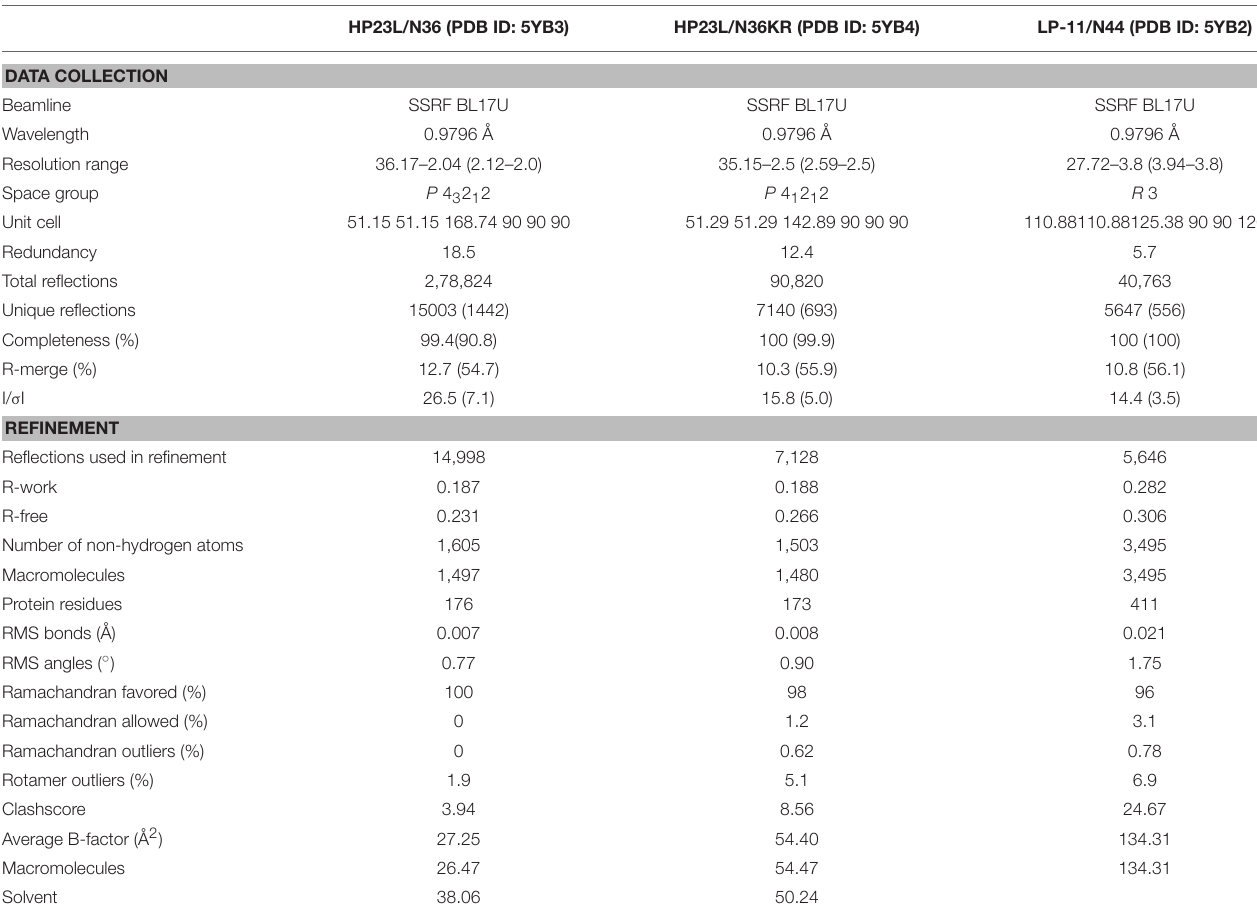
TABLE 1 | Data collection and